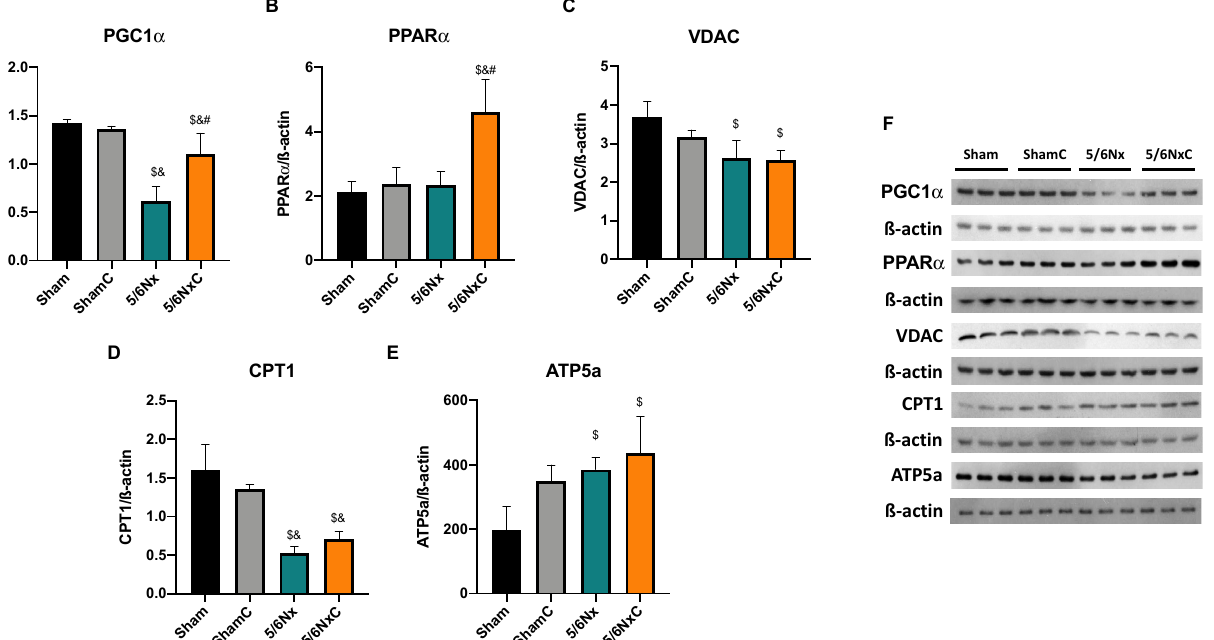
Figure 9. Liver mitochondrial biogenesis and β -oxidation related proteins in the four groups of rats studied: Sham, Sham + curcumin (ShamC), five-sixths nephrectomy (5/6Nx), and 5/6Nx + curcumin (5/6NxC). ( A ) Peroxisome proliferator-activated receptor γ co-activator 1 α (PGC1 α ), ( B ) Peroxisome proliferator-activated receptor α (PPAR α ), ( C ) voltage-dependent anion channel (VDAC), ( D ) Palmitoyl carnitine transferase 1 (CPT1), ( E ) ATP synthase 5a (ATP5a) and ( F ) representative images of western blot. β -actin was used as a loading control One-way analysis of variance (ANOVA), post hoc Fisher´s Least significant difference (LSD), Mean ± SD, n = 3. $ p < 0.05 vs. Sham, & p < 0.05 vs. ShamC, # p < 0.05 vs. 5/6Nx.